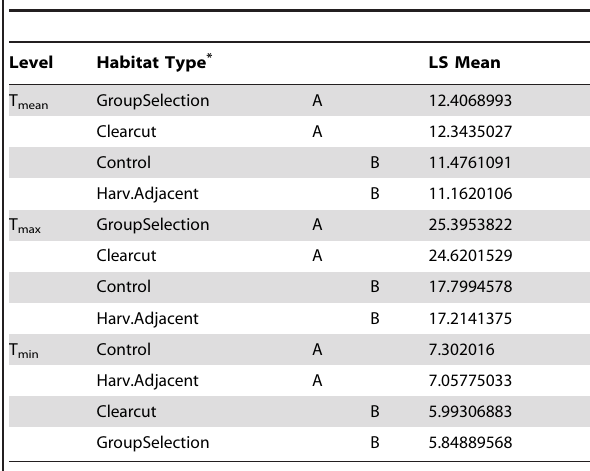
Table 2. Least Squares Means (LS Mean) Tukey-Kramer post- hoc pairwise comparisons connecting letters report of monthly environmental temperatures (Tmin, Tmax, Tmean) during 2009–2010 within four habitat types (clearcut openings, group selection openings, harvest-adjacent forest, and forested control).